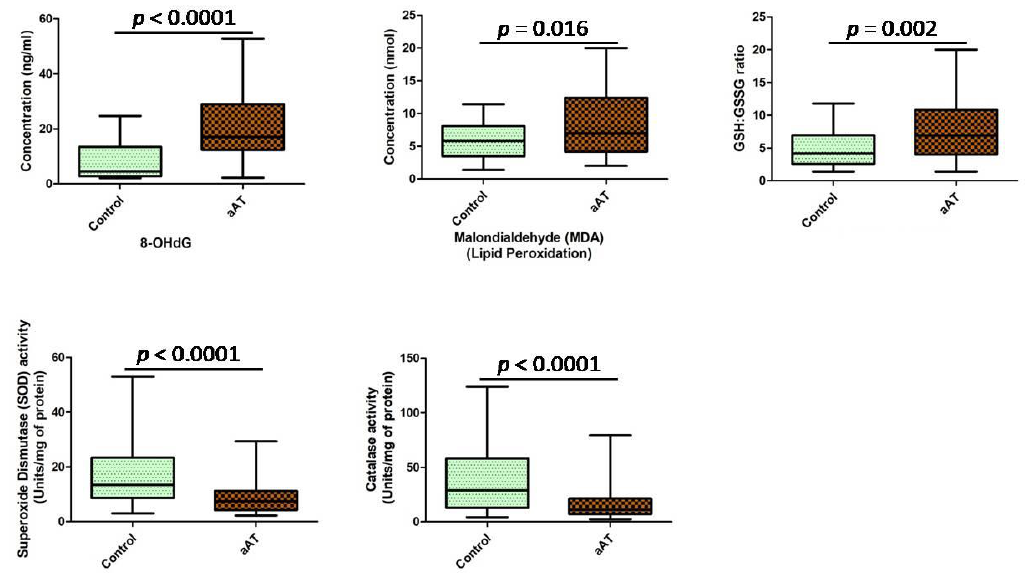
Figure 4. Status of oxidative stress-associated markers in the cultured macrophages after challenging with IL-33-primed neutrophils/NETs in the aAT patient and controls groups (8-OHdG = 8-hydroxy- 2′ -deoxyguanosine).